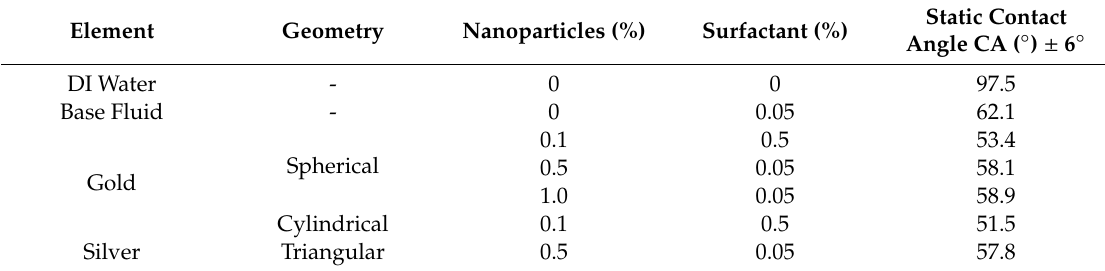
Table 2. Static contact angle for the different nanofluids.